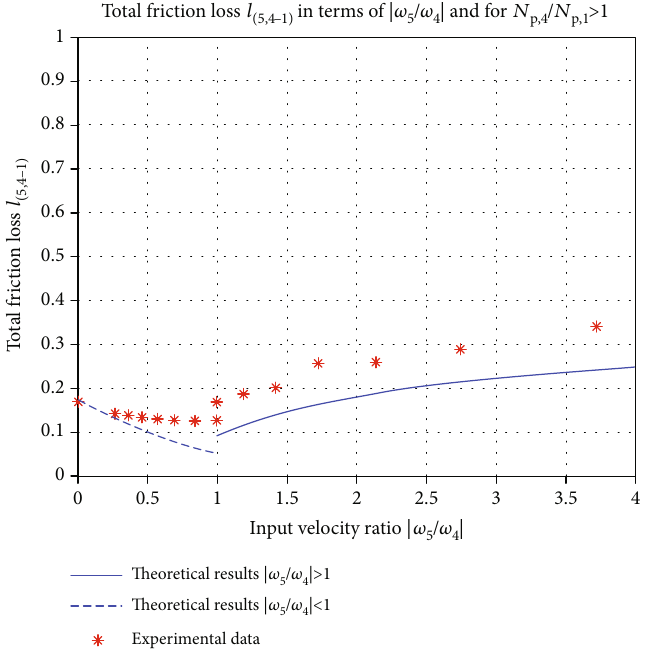
Figure 11: Comparison between the experimental data and theoretical